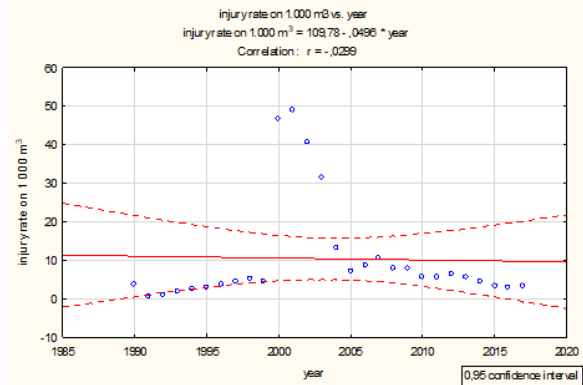
Figure 3: Trend in the injury rate on 1 000 m 3 in Slovakian state forests (years